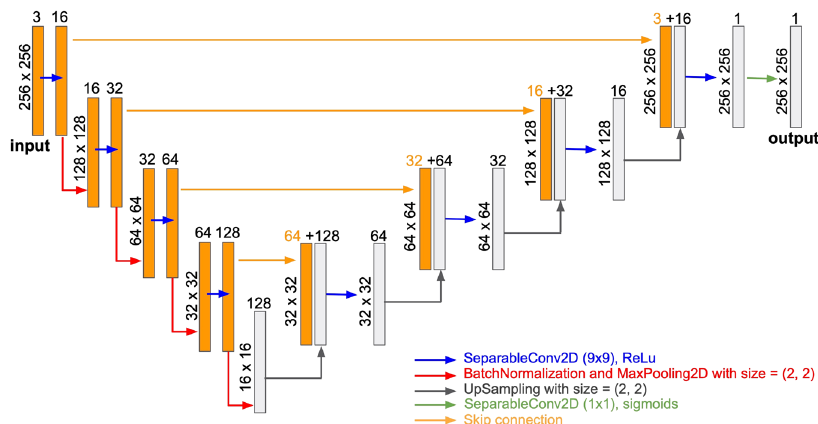
Fig. 8 Architecture of the U-Net used in this work. Here, the notation of Tensor fl ow 55 is adopted for naming the layers. The layers consist of separable convolutional layers (SeparableConv2D) with either a recti fi ed linear unit (ReLu) or sigmoid activation functions to extract the features and apply the non-linearities, batch normalization (BatchNormalization) to transform the layers ’ outputs to a mean value of zero and a standard deviation of 1, max pooling (MaxPooling2D) for coarse-graining, and up sampling (UpSampling2D) for going from the coarse grained image to a high resolution one. The skip connections send the images from each contracting step to its expanding